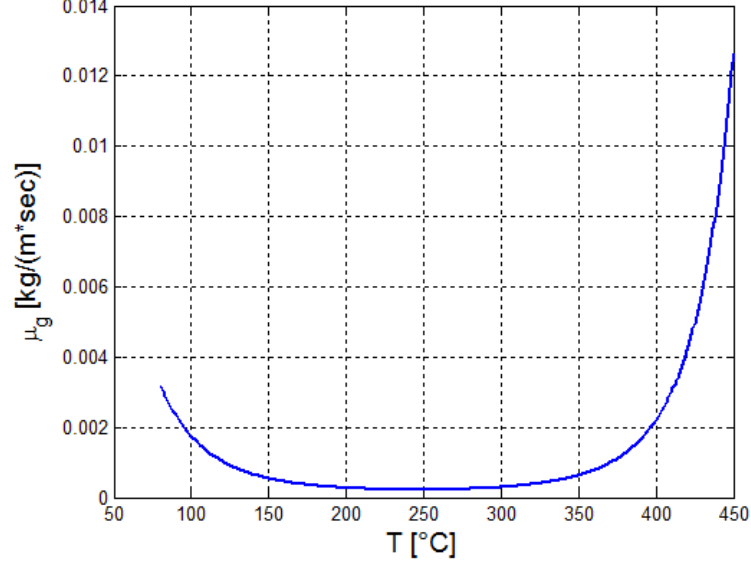
Figure 12. The viscosity of liquid crude oil.